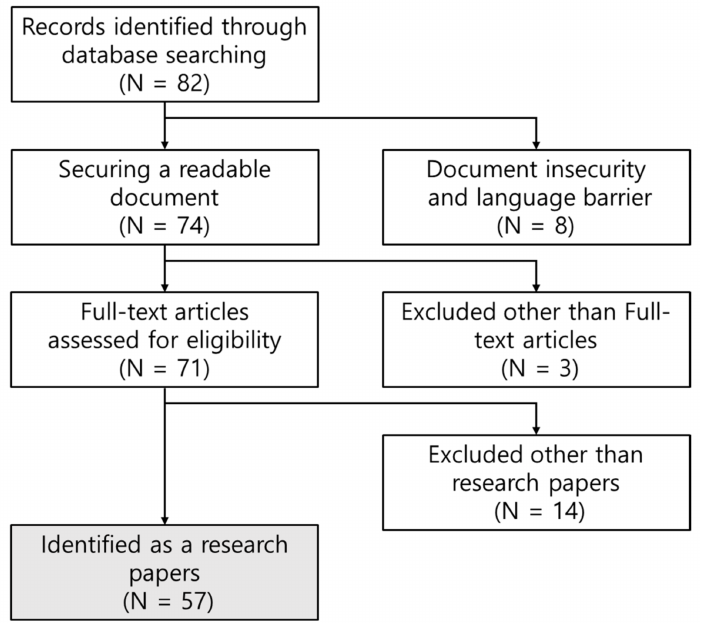
Figure 2. Flow chart of selection